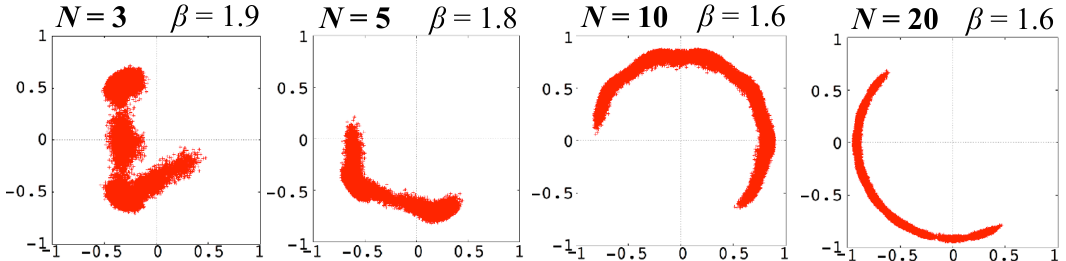
Figure 3 . Distribution plots of the Polyakov loop for N = 3 ; 5 ; 10 ; 20 with ( N s ; N (cid:28) ) = (200 ;